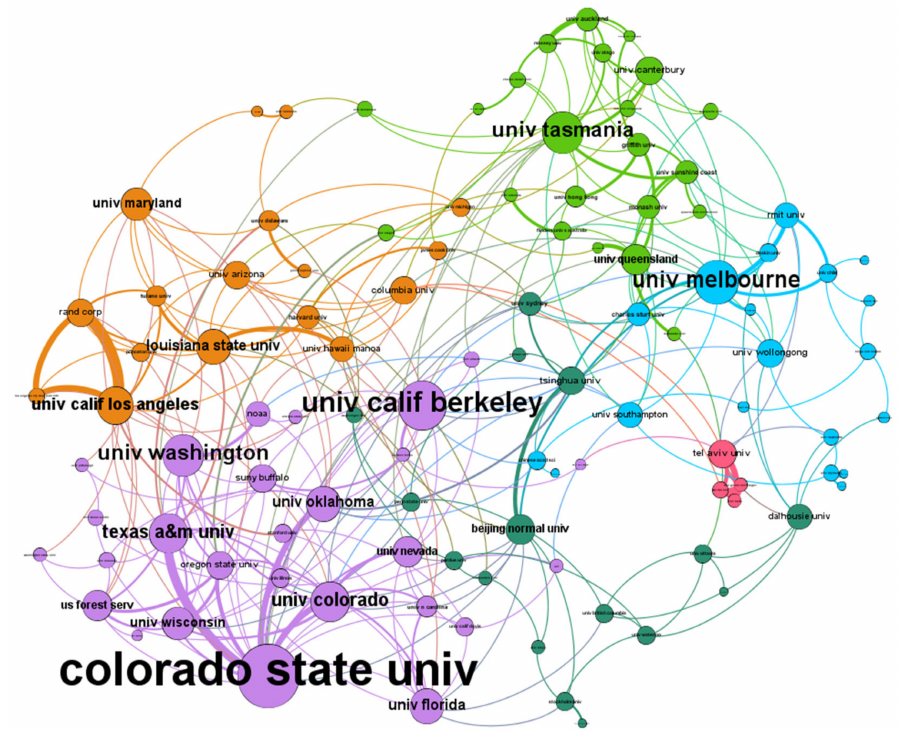
Figure 5. Visualization map of cooperation network between high-yield institutions in community resilience research from 2001 to 2020. Note that the size of the circle represents the weight of the connection and the thickness of the connection represents the number of